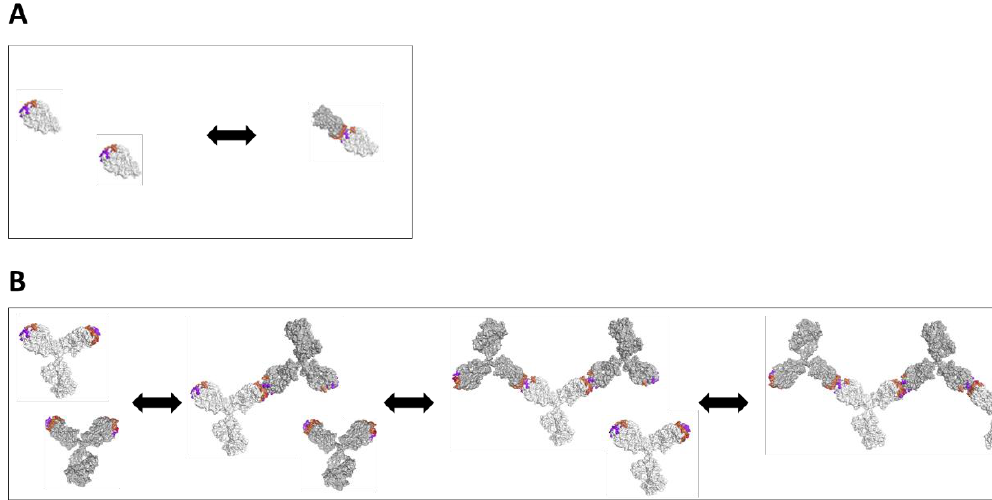
Figure 3. Model depicting ( A ) face-to-face interaction of the Fab forms yielding a dimer/monomer equilibrium and ( B ) biva- lent mAb form yielding oligomerization and larger structures that alter bulk solution rheology (up to a tetramer shown) .